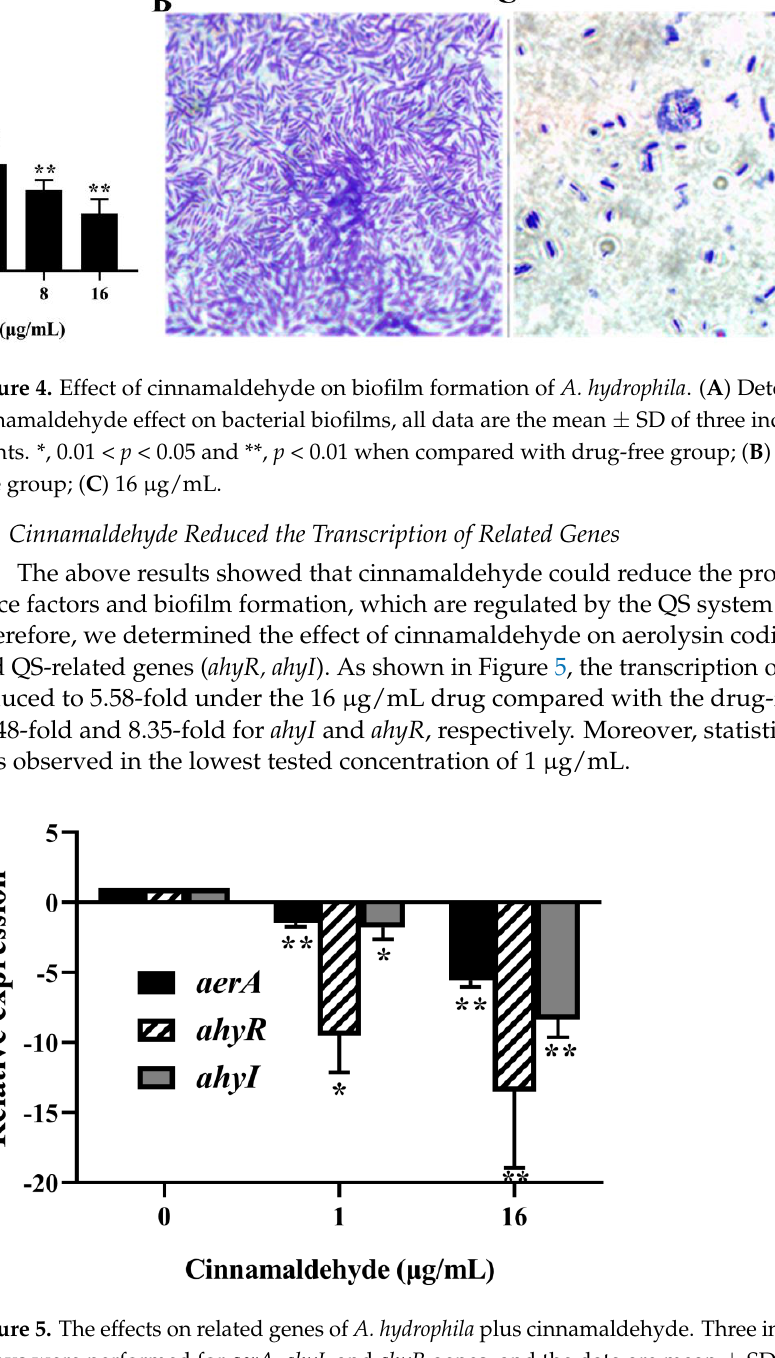
Figure 3. Effects of cinnamaldehyde on swarming motility. ( A ) DMSO control group; ( B ) 1 μg/mL; ( C ) 2 μg/mL; ( D ) 4 μg/mL; ( E ) 8 μg/mL; ( F ) 16 μg/mL; ( G ) swarming diameter. All data are presented as mean ± SD in the swarming diameter of three independent experiments. **, p < 0.01 when compared to the DMSO group.